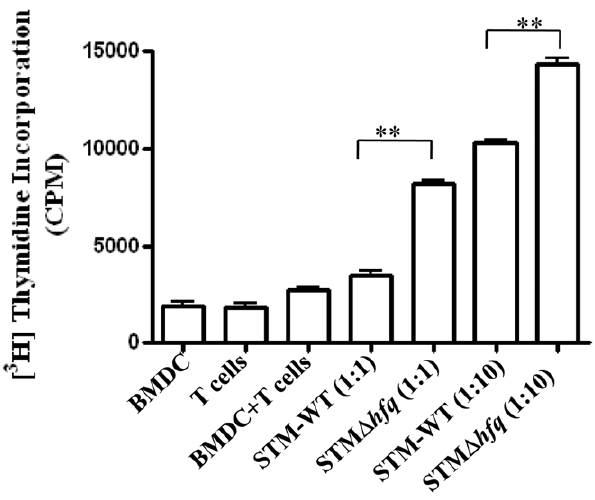
Figure 9. Increased antigen presentation of the STM D hfq by Denditic cells. Dendritic cells were isolated from the BALB/C mice and were plated at 5 6 10 4 cells/well in 96 well flat-bottomed tissue culture plates. C57BL/6 mice were infected with STM-WT for pre stimulation and T-lymphocytes were isolated on 5 th day aseptically. DCs were infected with the STM-WT and STM D hfq . The infected DCs were then co-cultured with T-lymphocytes at a ratio of (1:1) and (1:10) for 72 h and then pulsed for 16 h with [ 3 H] thymidine (1 m Ci/well). The incorporation of [ 3 H] thymidine in proliferating T cells were measured by liquid scintillation counter. T cell proliferation was represented counts/min using a beta-counter. The results are representative of two independent experiments in triplcate. Statistical significance was defined as follows: (*p , 0.05) (Student’s t test).